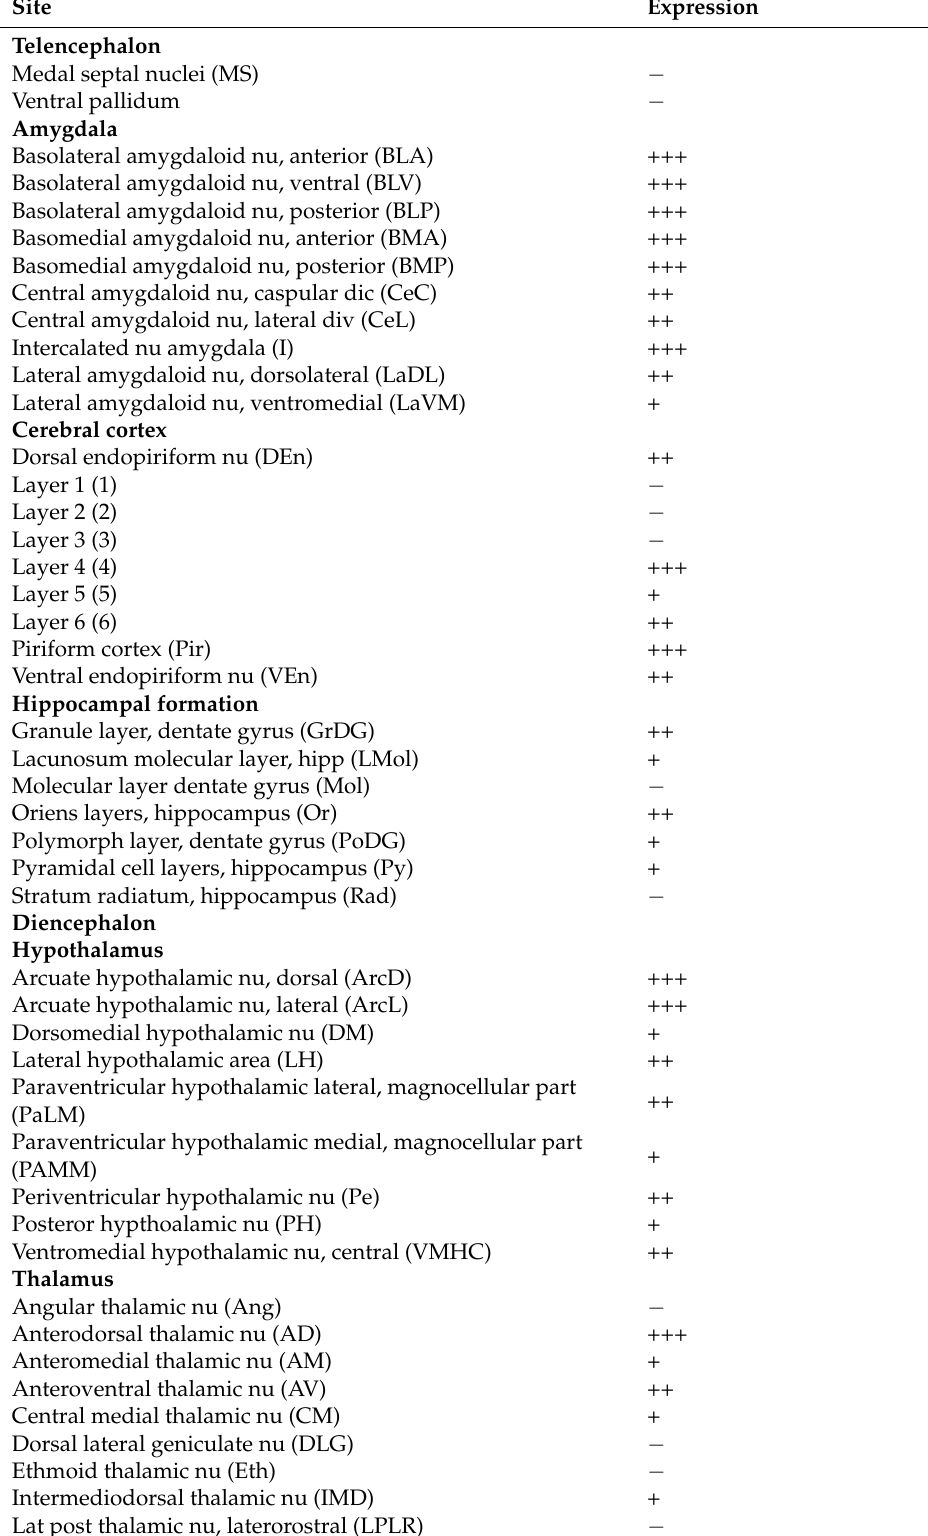
Table 2. Graded levels of Hmgcr mRNA expression in the mouse brain. A sign − means that no expression of Hmgcr mRNA was detected by RNA in situ hybridization. The signs +, ++ and +++ mean significant Hmgcr mRNA detection with respect to the areas without detection with p < 0.05, p < 0.01, p < 0.001,